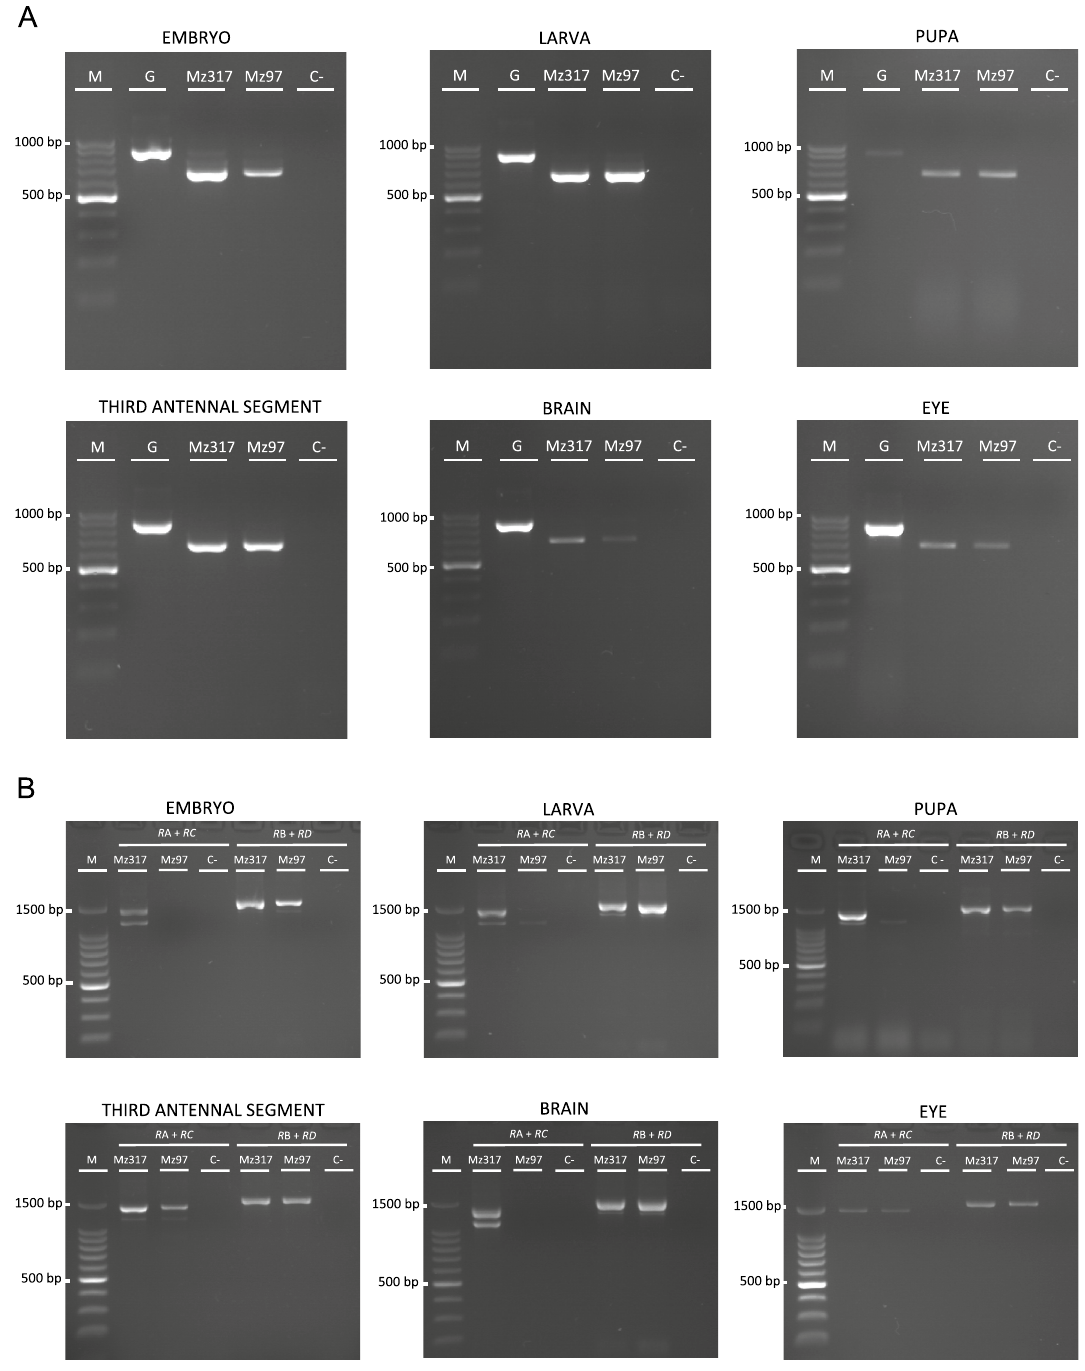
Figure 5. Gene expression analysis of Ntan1 in Mz97-Gal4 and Mz317-Gal4 fly lines. Expression of the Ntan1 gene ( A ) and Ntan1 transcripts ( B ) by RT-PCR in Mz97-Gal4 and Mz317-Gal4 fly lines. M: Molecular marker, G: Genomic DNA of wildtype genotype, Mz317: Mz317-Gal4 cDNA , Mz97: Mz97-Gal4,UAS-Stinger cDNA and C−: Negative